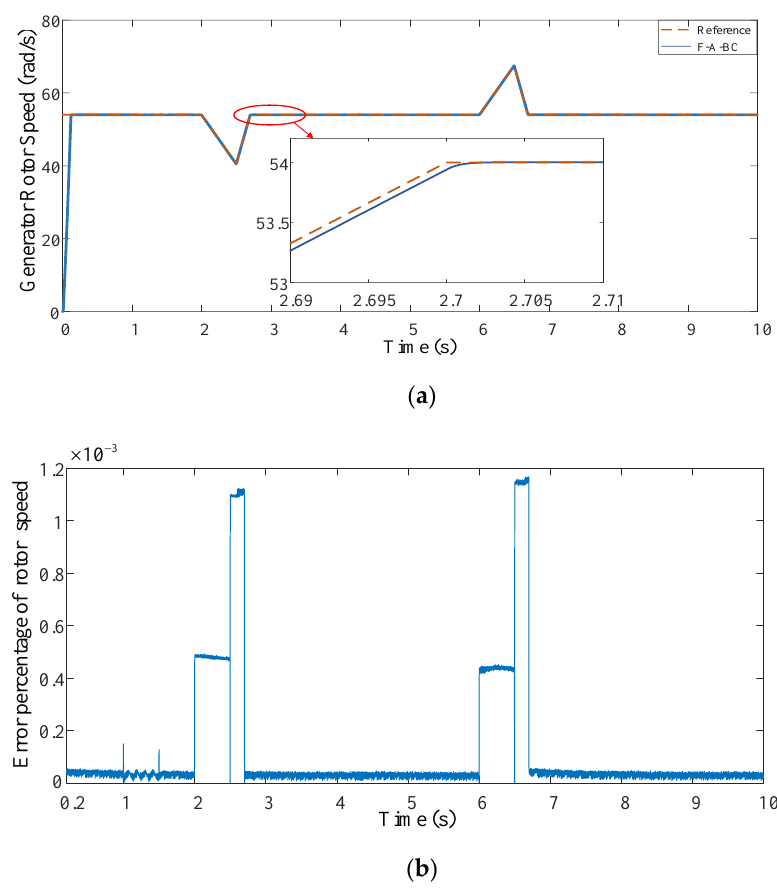
Figure 7. The rotor speed and the error percentage of the rotor speed under marine current and torque disturbances. ( a ) The rotor speed response; ( b ) the error percentage of rotor speed.